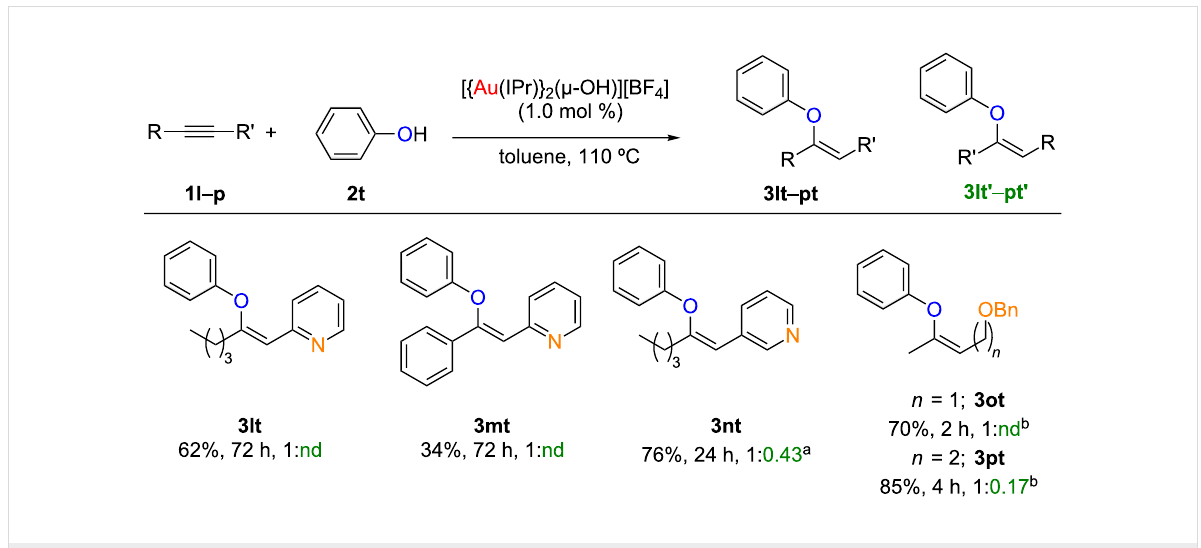
Scheme 5: Regioselective hydrophenoxylation of unsymmetrical alkynes. Reaction conditions: 1l – p (1 equiv), 2a (1.1 equiv), [Au] (1 mol %), toluene (1 mL), 110 °C. Isolated yields, average of two runs. Ratio determined by 1 H NMR. nd = not detected. a [Au] (3 mol %). b [Au] (0.5 mol %), 1o (2